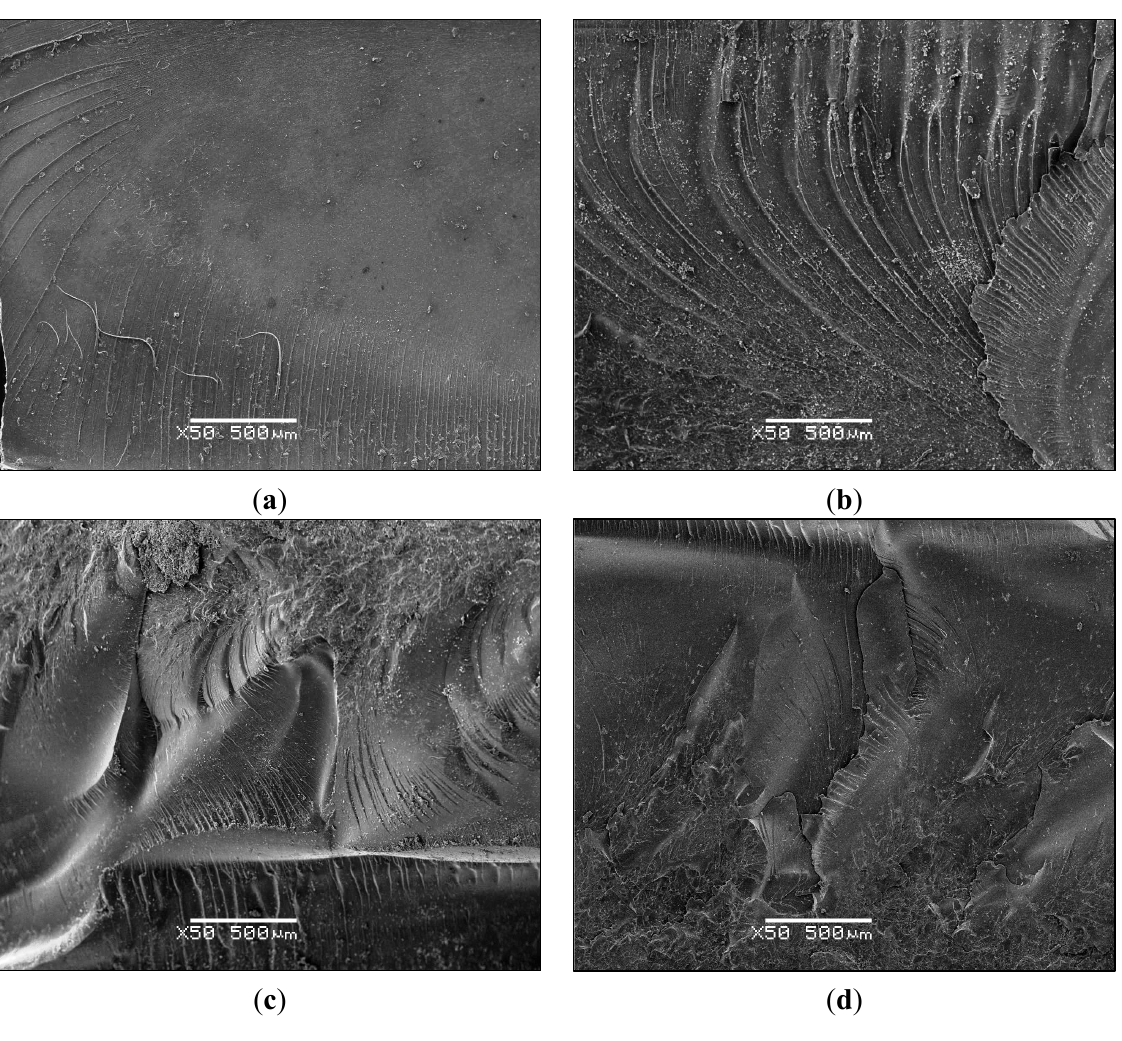
Figure 16. SEM micrographs of the fracture surfaces of 2 wt% MMT nanocomposite samples after impact testing: ( a ) reference, TGAP/DDS without any clay; ( b ) 2%, 150